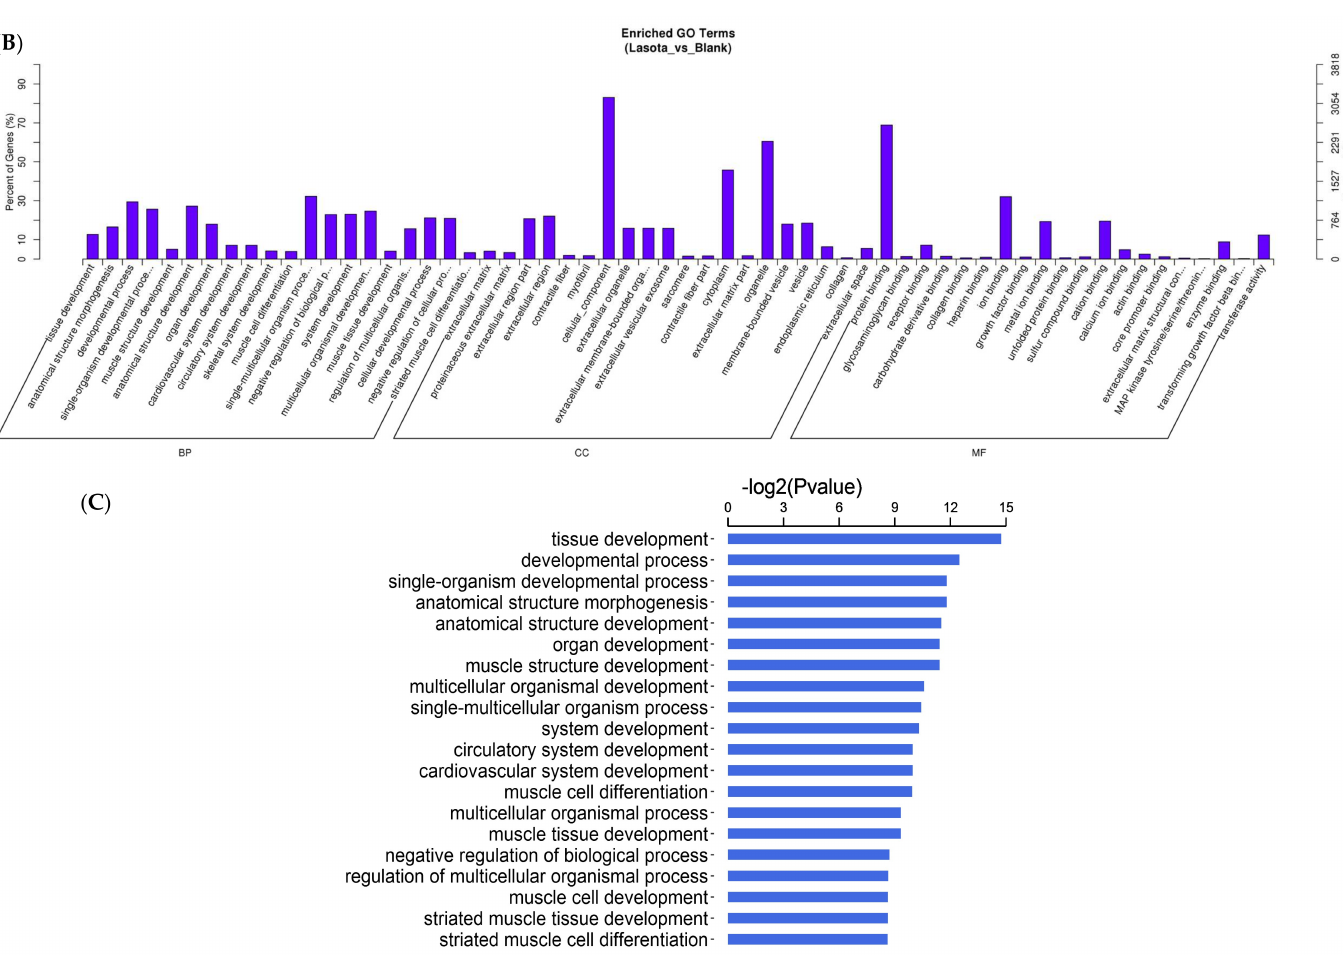
Figure 2. Gene ontology (GO) functional enrichment of differentially expressed genes. ( A ) GO analyses of differentially expressed genes in Herts/33 relative to the control; ( B ) GO analyses of differentially expressed genes in LaSota relative to the control; and, ( C ) GO analyses of differentially expressed genes common to both strains. Development processes were found to be the most enriched biological processes, judging by p